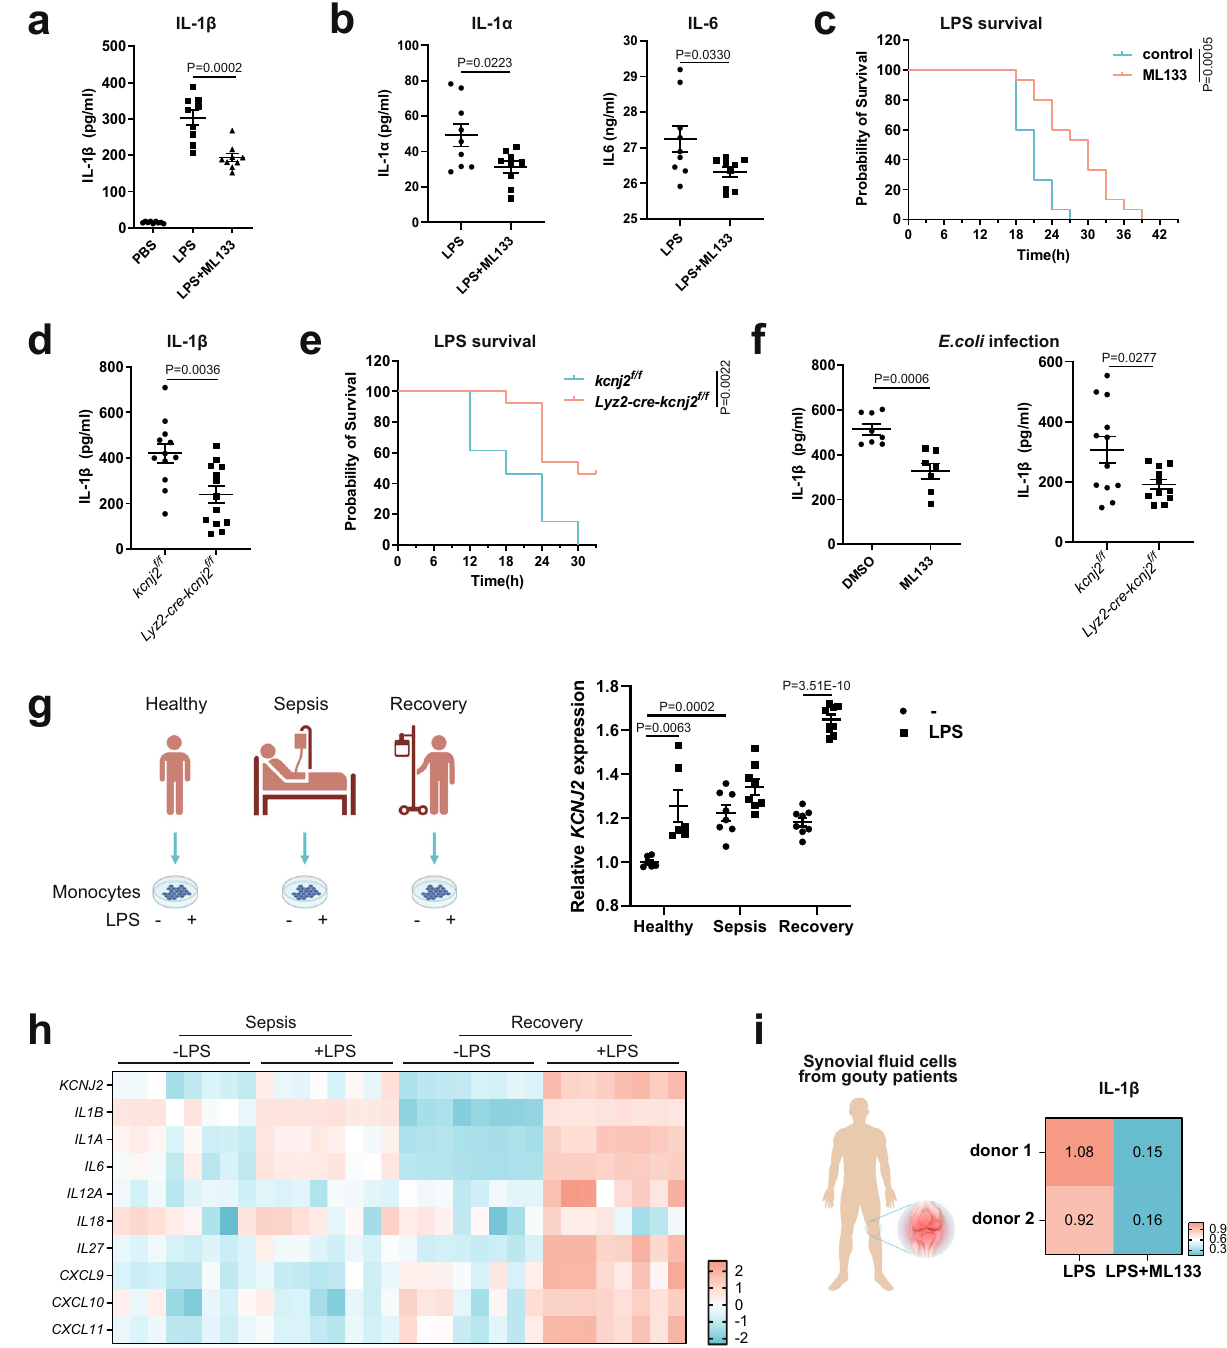
Fig. 7 Kir2.1 repression alleviates in fl ammation triggered by pathogenic or danger signals in mouse models and human samples. a IL-1 β levels in serum from septic mice measured by ELISA. ( n = 9; mean ± SEM) ( b ) IL-1 α and IL-6 levels in serum from septic mice measured by ELISA. ( n = 9, mean ± SEM) ( c ) Survival rates of sepsis model mice ( n = 15, log-rank test [Mantel – Cox]). d IL-1 β levels in serum from septic mice measured by ELISA ( Kcnj2 f/f , n = 12; Lyz2- cre-Kcnj2 f/f , n = 13; mean ± SEM). e Survival rates of sepsis model mice ( n = 13; log-rank test [Mantel – Cox]). f IL-1 β levels in serum from septic mice measured by ELISA (DMSO, n = 8; ML133, n = 7; Kcnj2 f/f , n = 12, Lyz2-cre-Kcnj2 f/f , n = 11; mean ± SEM). g The expression of KCNJ2 in monocytes from healthy donors, sepsis patients, and those who recovered from sepsis with or without LPS 63 . Data sourced from the GEO database (GSE46955). ( n = 6, 8, 8 respectively; mean ± SEM). h Heatmap showing the expression of Kir2.1 and in fl ammatory genes in monocytes from septic patients and those who recovered from sepsis in response to LPS 63 . Data sourced from the GEO database (GSE46955). ( n = 8, 8 respectively; mean ± SEM). i Relative IL-1 β levels in the supernatant of cultured synovial fl uid cells from two gouty patients analyzed by ELISA. Two-tailed unpaired Student ’ s t -test. Source data are provided as a Source Data fi